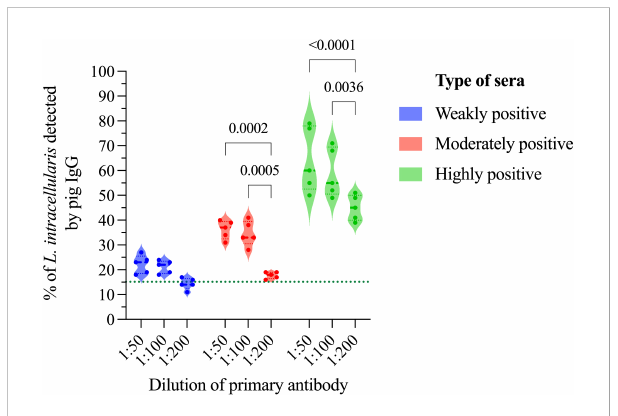
FIGURE 5 Primary antibody dilution and its impact on serology interpretation.